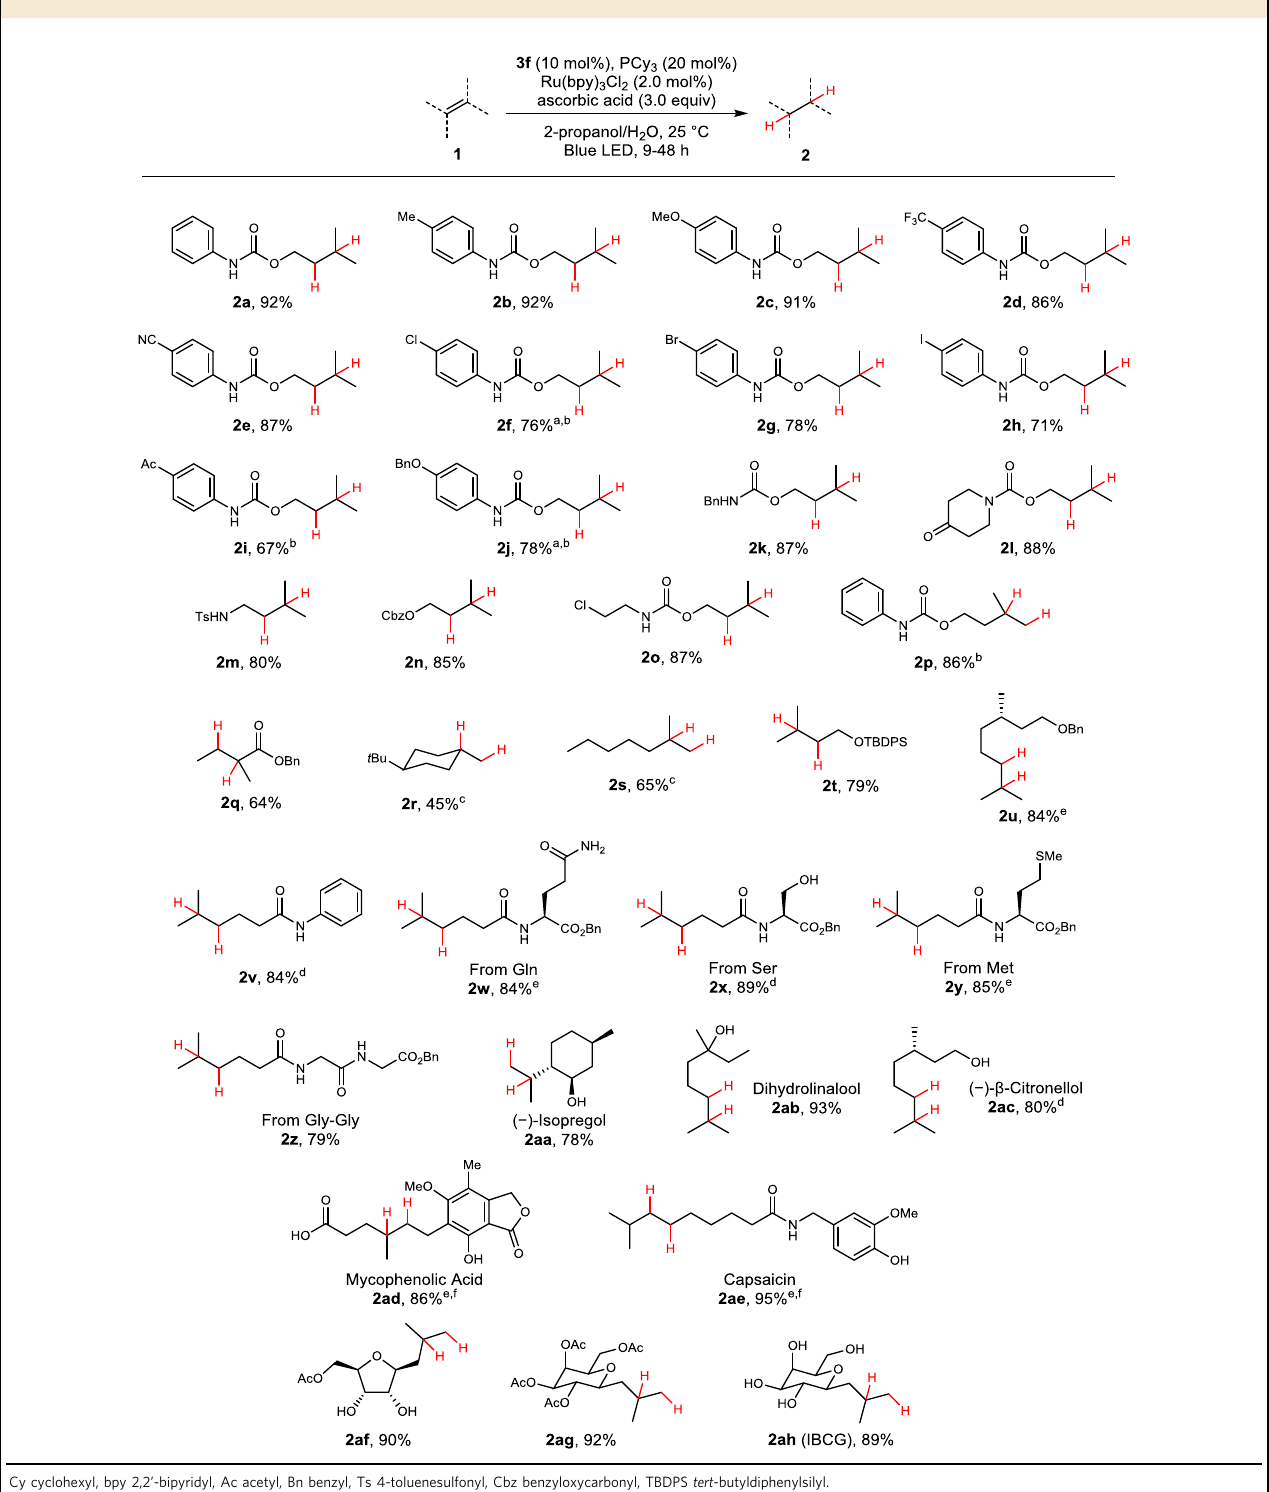
Table 2 Scope of the ascorbic-acid-mediated hydrogenation of